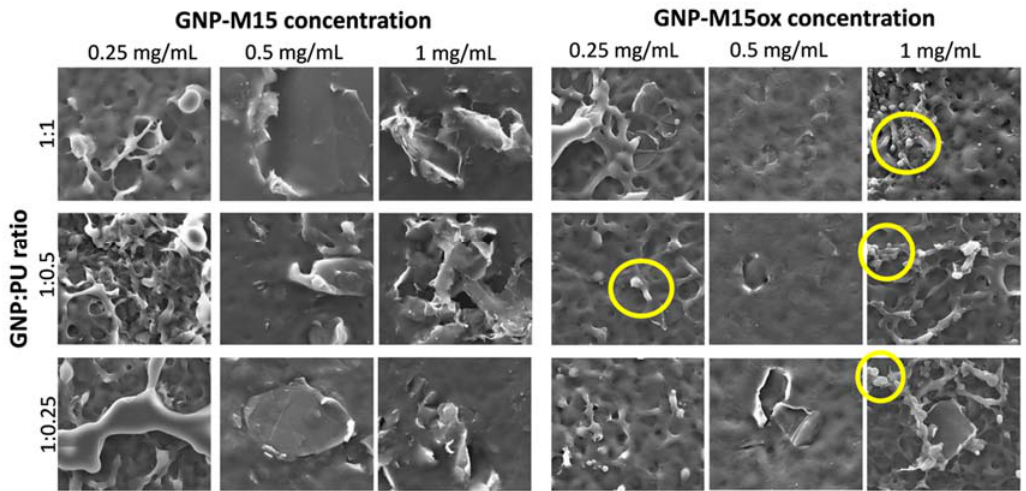
Figure 5. Characterization of PU / GNP coatings: surface topography of PU film (substrate), PU coating (PU coating on PU substrate) and PU / GNP coatings with di ff erent GNP concentration and GNP:PU ratio produced by dip coating with di ff erent GNP concentration and GNP to PU weight ratio. Images were obtained by SEM (scale bar = 10 µ m); yellow circles indicate spherical agglomerates observed in the surfaces.